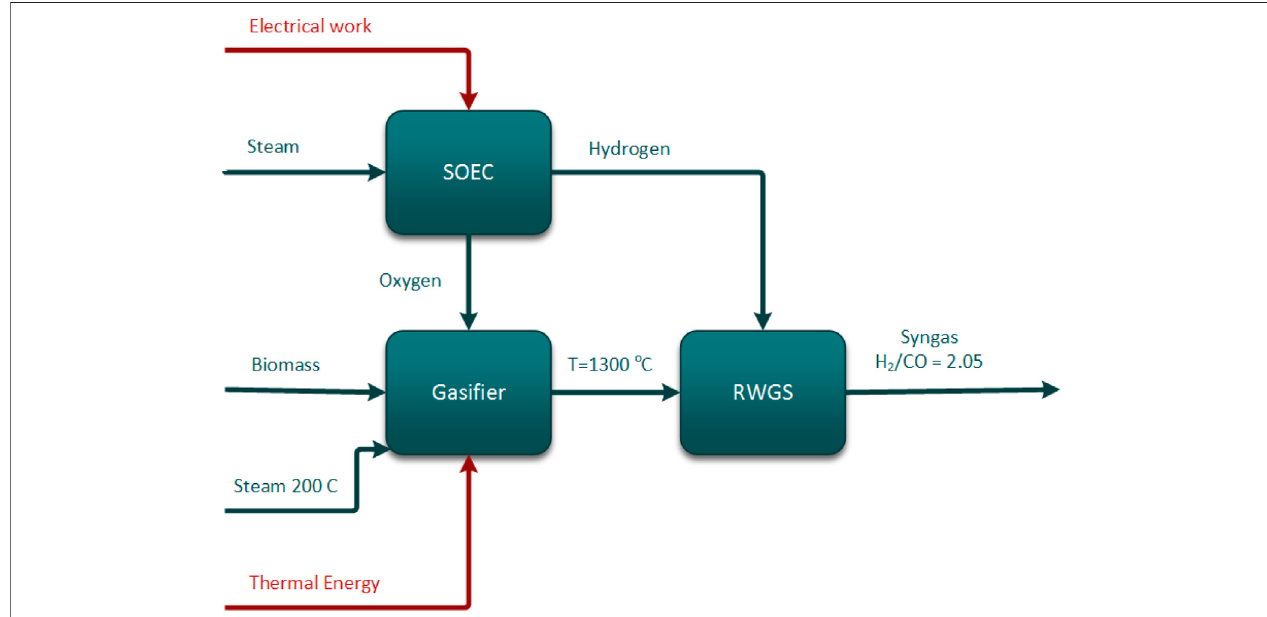
FIGURE 1 | Process concept diagram for integration of renewable energy into syngas generation from biomass gasi fi cation.